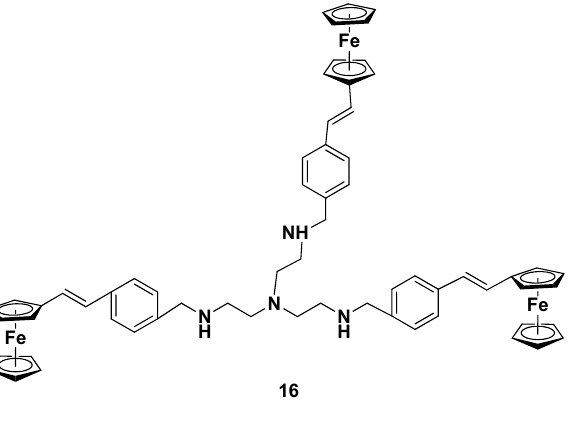
Figure 9. Structures of trinuclear ( 16 ) and a tetranuclear ( 17 ) ferrocenyl–amino complexes.